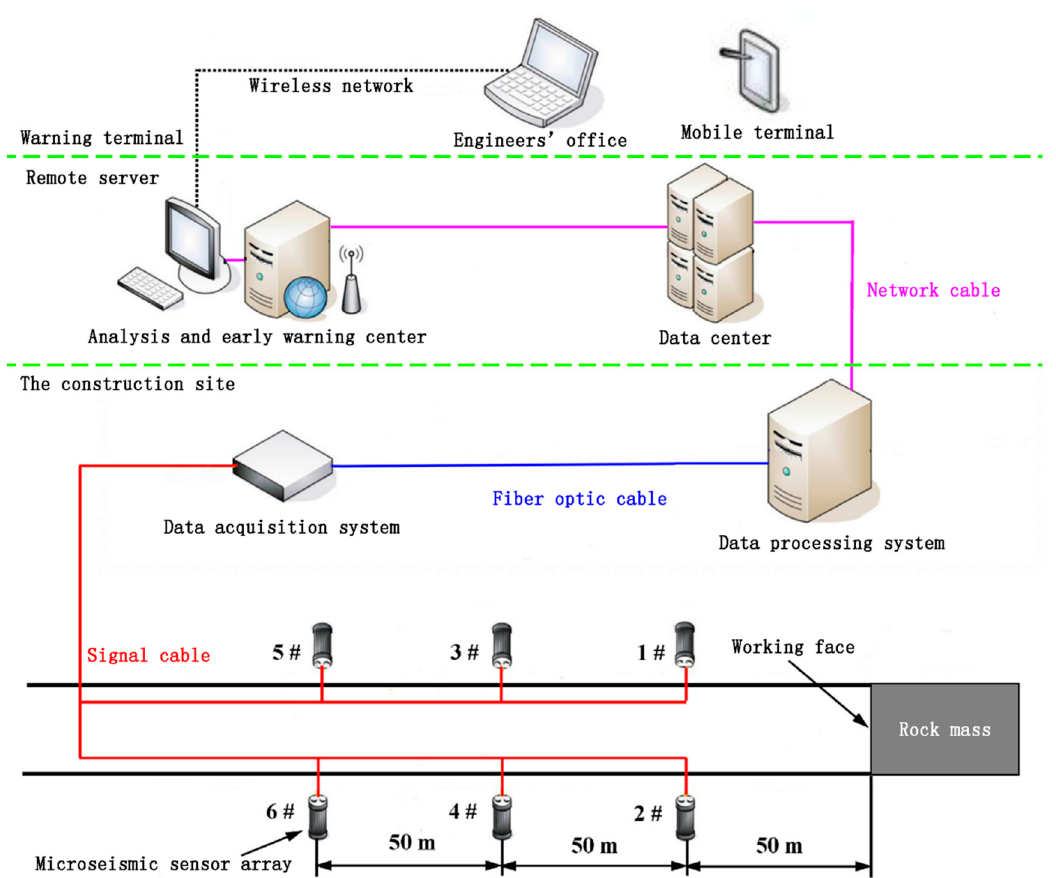
Figure 2. Topology diagram of a typical microseismic monitoring system in a tunneling environment.